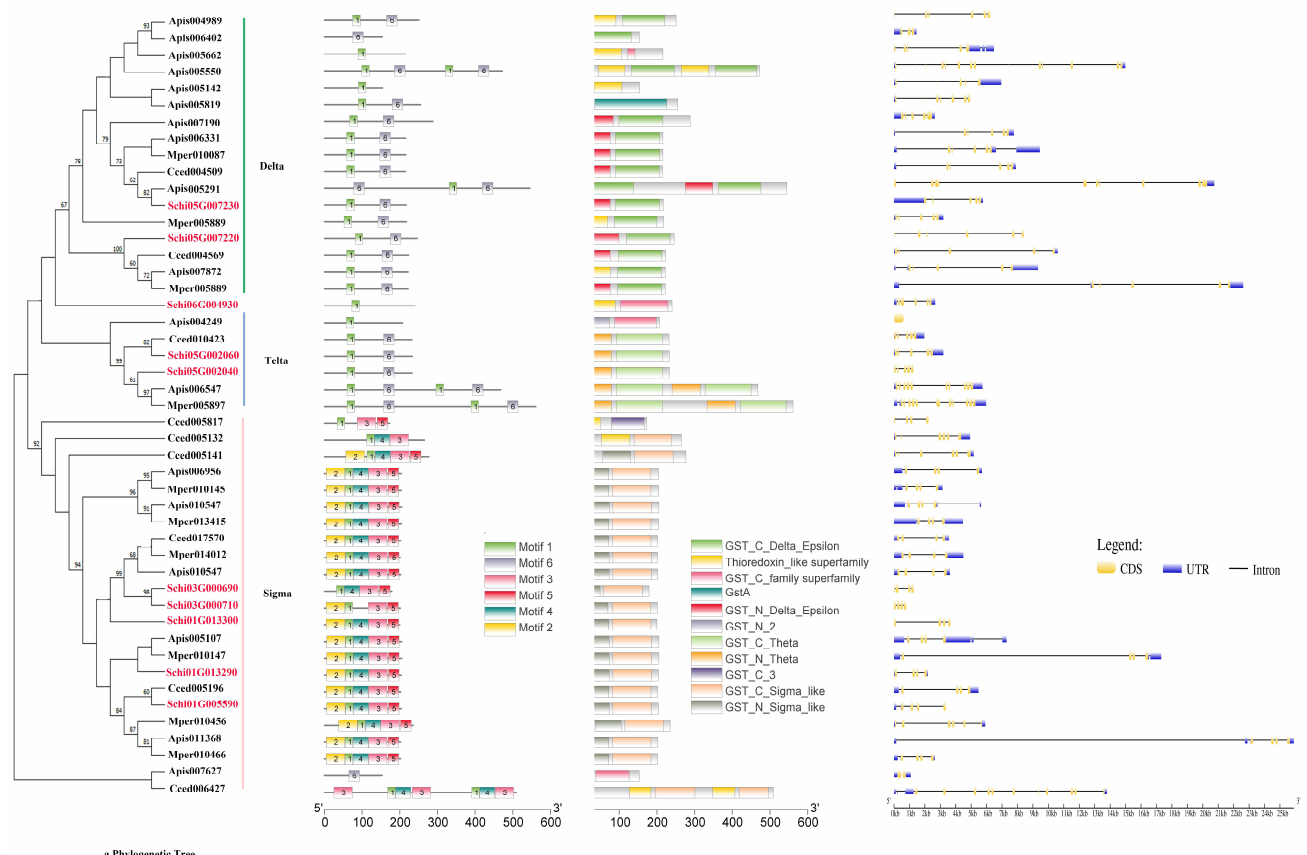
Figure 5. ( a ) Phylogenetic relationships, ( b ) conserved motifs, ( c ) domains and ( d ) gene structures of detoxification genes of the GST gene family in S. chinensis , A. pisum , C. cedri , and M. persicae .